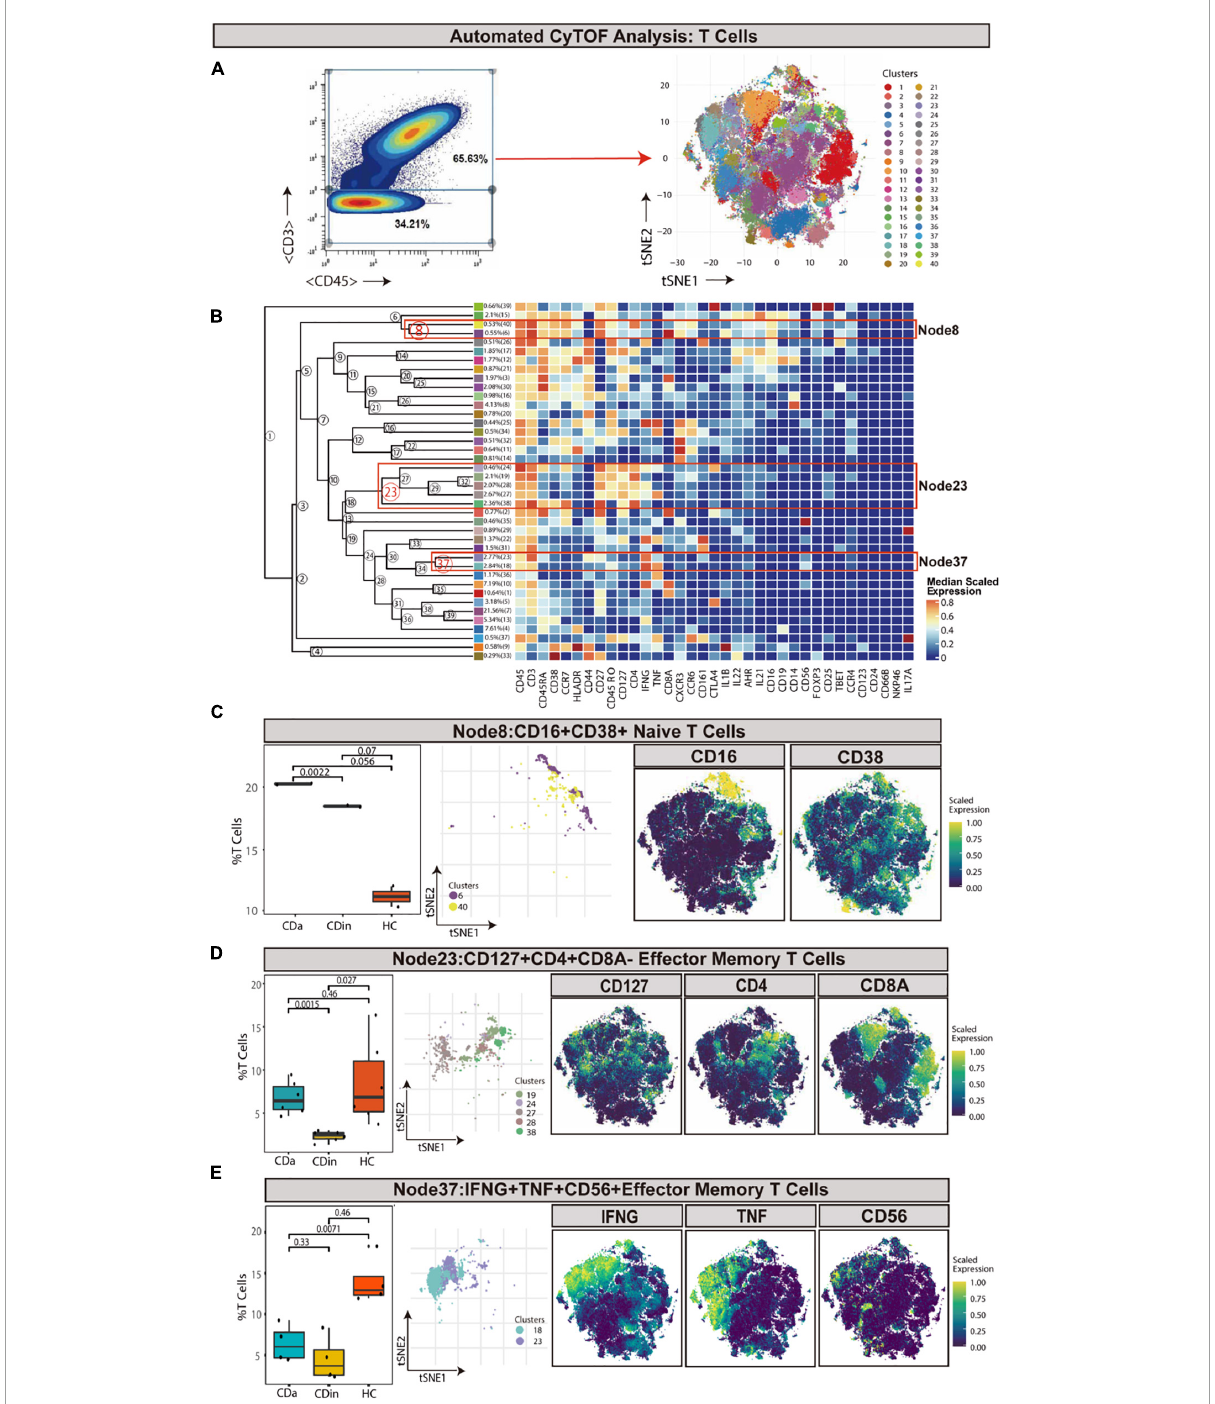
FIGURE1 CyTOF analysis showed differences in T cells among CDa, CDin, and HC. (A) Gating strategy to determine T cells (left) and t-SNE projection of selected T cells derived from CyTOF data just for visualization purposes (right). (B) Cluster dendrogram and heatmap of selected T cells displaying median scaled expression levels of all markers in each cluster. Branch numbers correspond to the cluster numbers in the t-SNE plot [from panel (A) ]. Selected nodes are circled in red, and the subset names are labeled on the right. (C) The percentage of selected Node8 in T cells among CDa, CDin, and HC groups with Wilcoxon rank-sum test results (left) and the t-SNE plot of Node8 with gene expression feature plot for CD16/CD38 (right). (D) The percentage of selected Node23 in T cells among three groups (left) and the t-SNE plot of Node23 with gene expression feature plot for CD127/CD4/CD8A (right). (E) The percentage of selected Node37 in T cells among three groups (left) and the t-SNE plot of Node37 with gene expression feature plot for IFNG/TNF/CD56